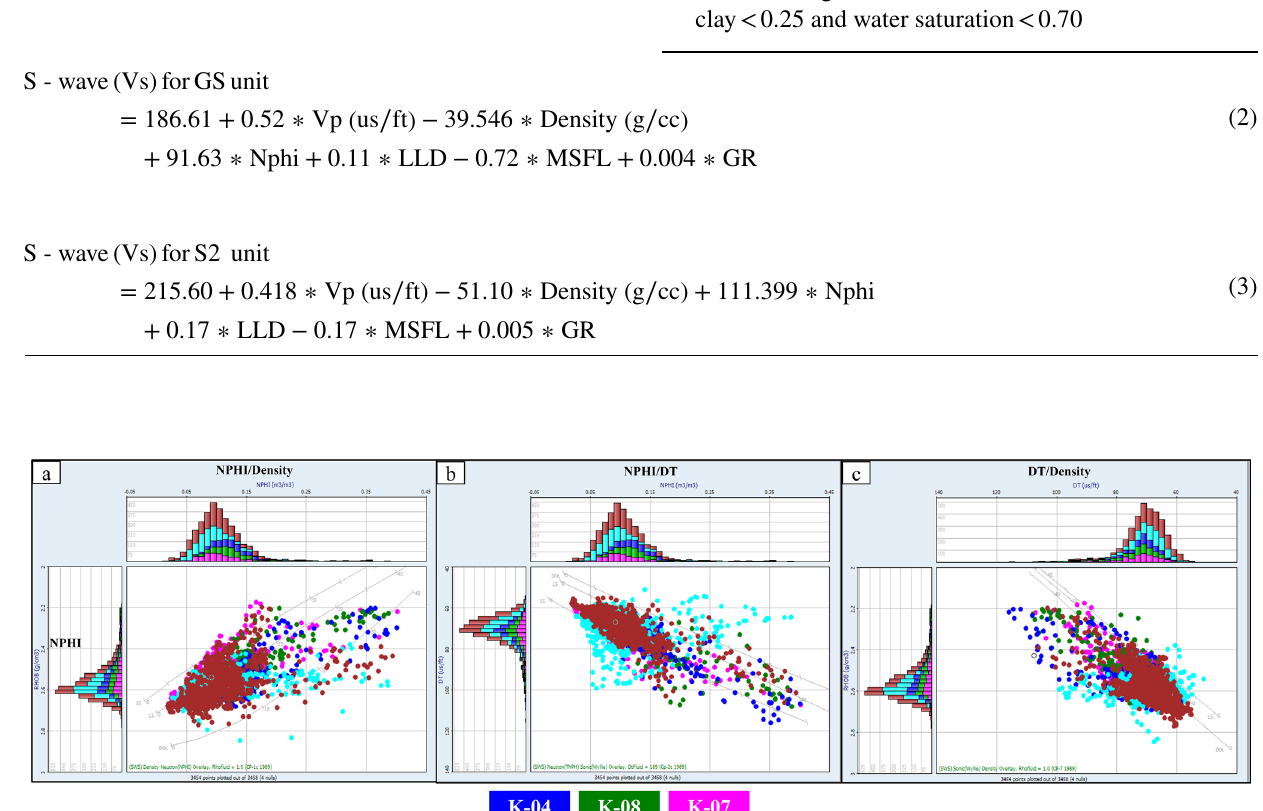
Fig. 6 Well-logs data conditioning workflow